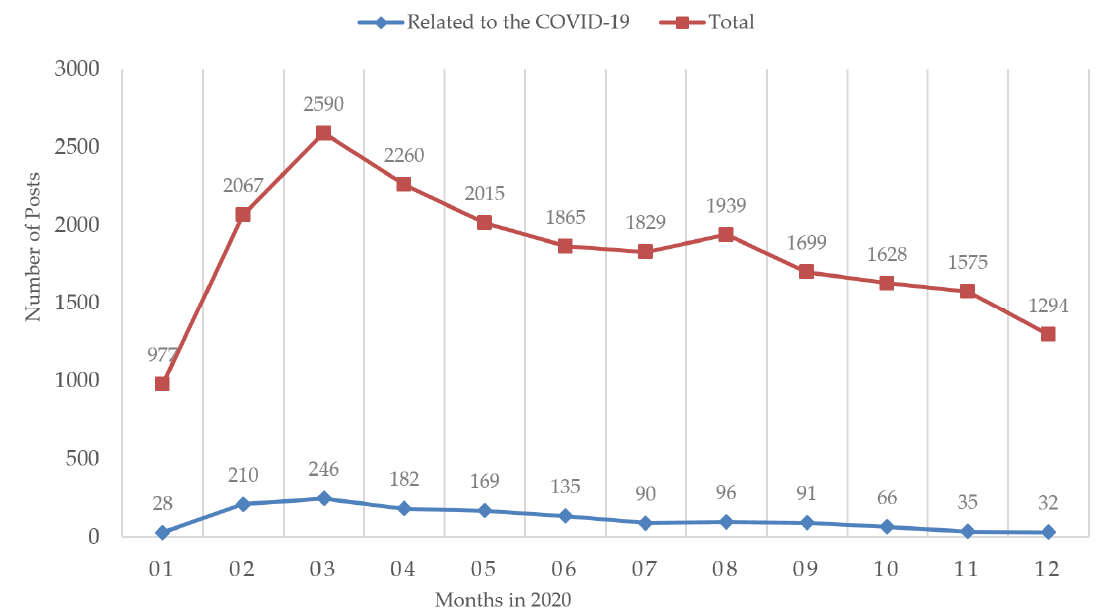
Figure 7. The monthly trends of the number of PHS posts during the COVID-19 pandemic.